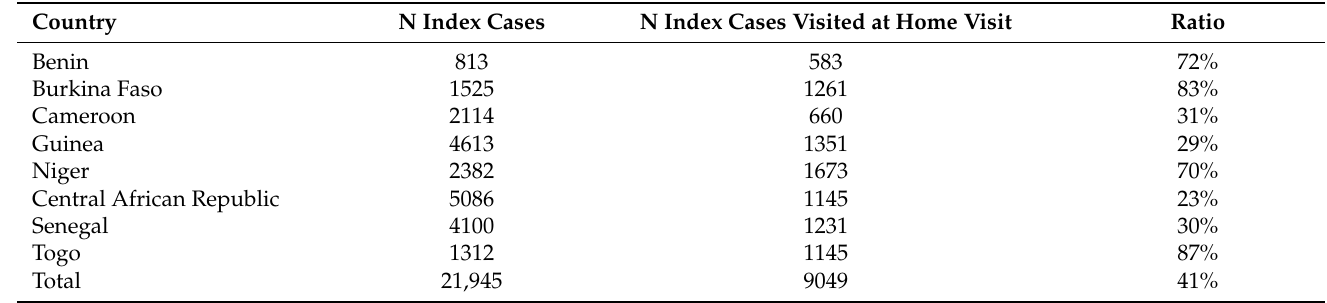
Table 1. Proportion of home visits performed among index cases, Q4 2020 to Q4 2021.